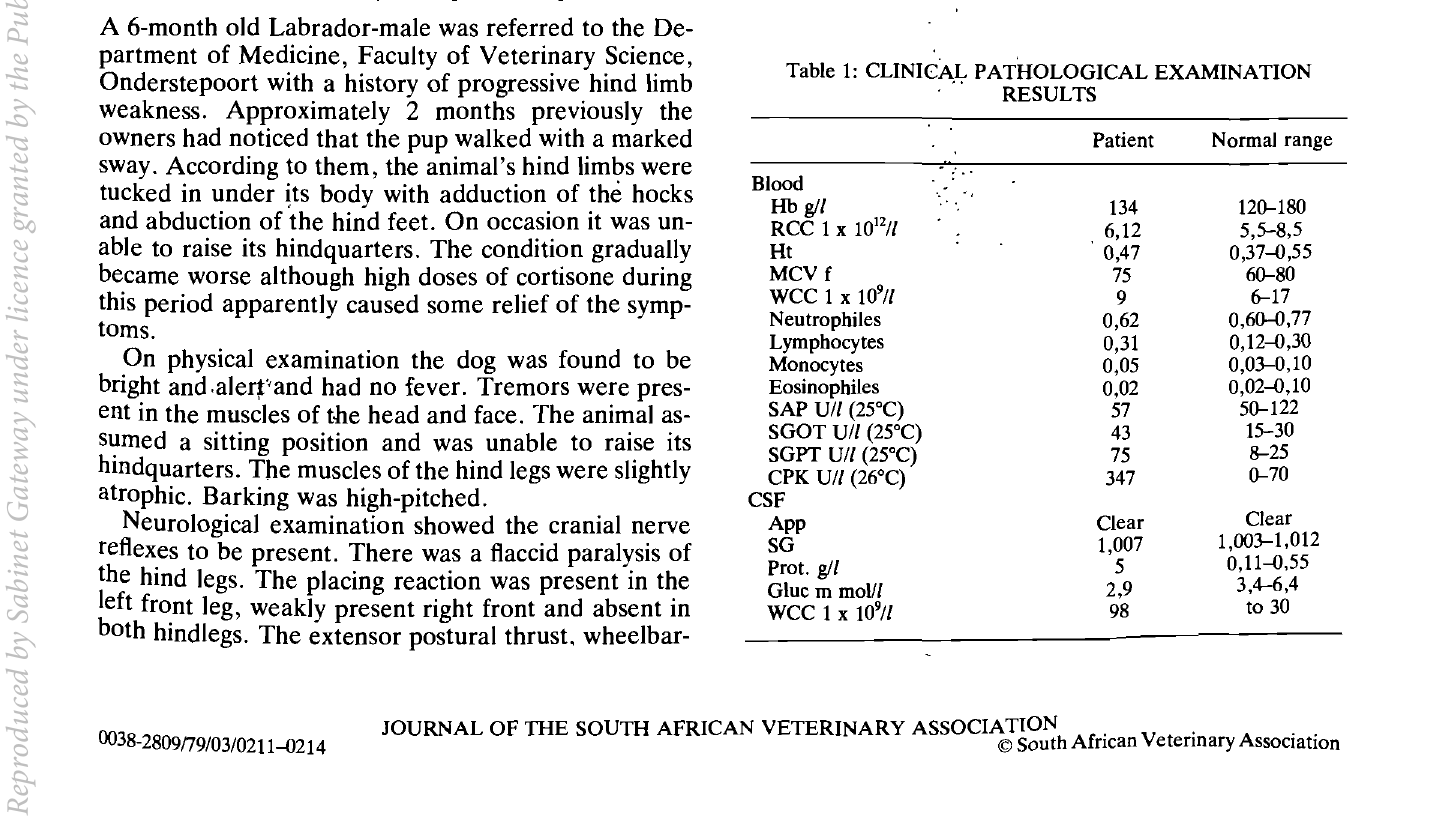
Table 1: CLINICAL PATHOLOGICAL EXAMINA nON